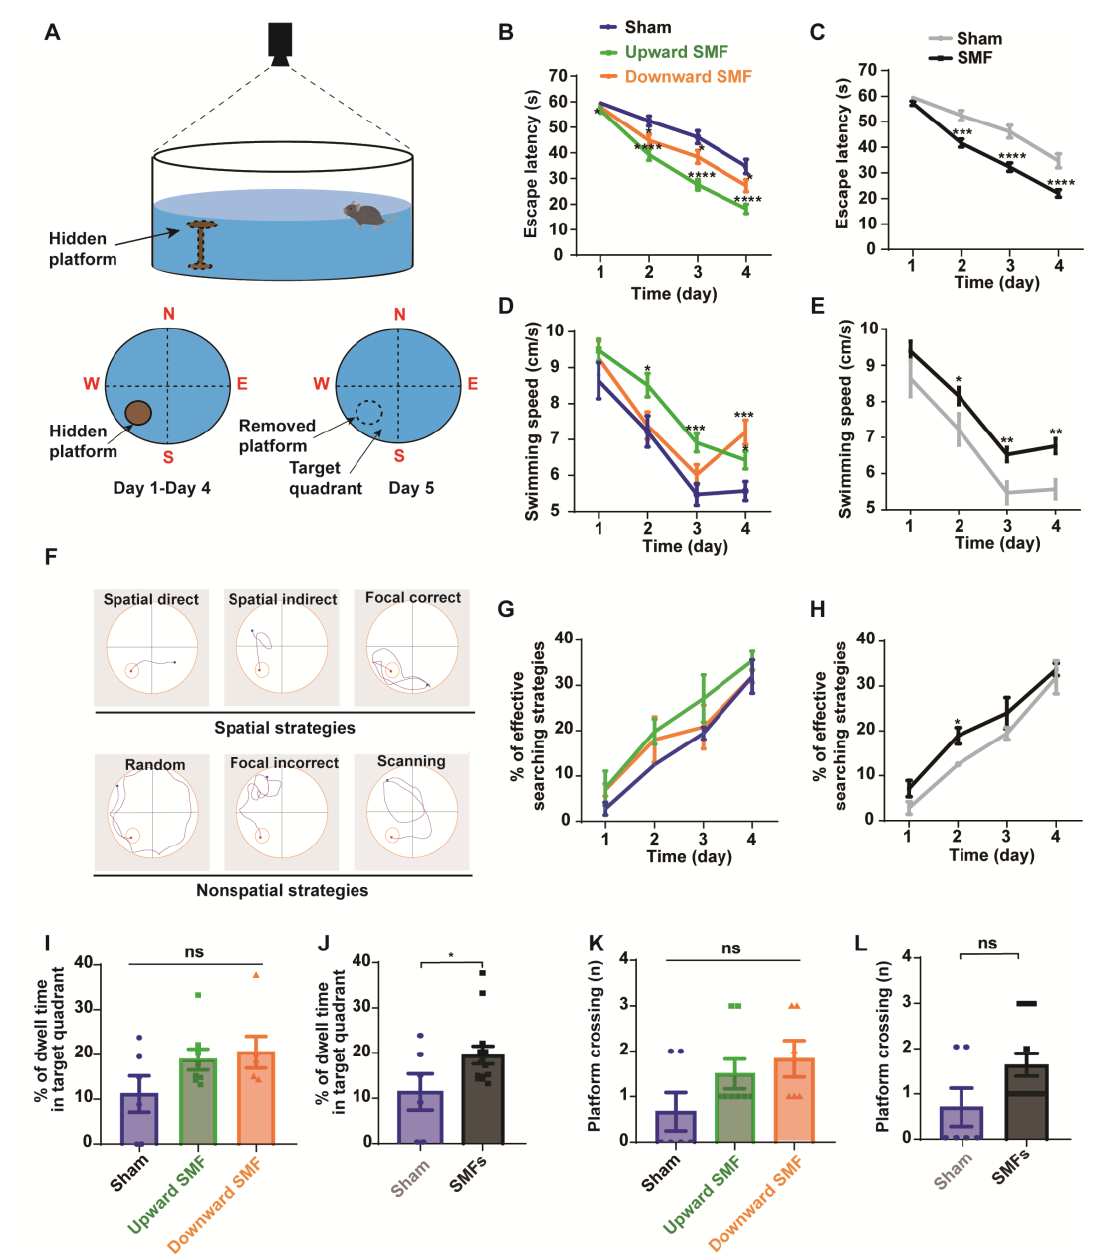
Figure 4. Morris water maze test shows that SMFs could improve spatial learning ability and spatial memory of aged mice. ( A ) Illustration of Morris water maze device, ( B , C ) escape latency during the spatial acquisition training days, ( D , E ) swimming speed during the spatial acquisition training days, ( F ) different types of search strategies during the spatial acquisition training days, ( G , H ) the percentage of effective searching strategies during the spatial acquisition training days, ( I , J ) the percentage of dwell time in the target quadrant during the probe trial, ( K , L ) platform crossing during the probe trial were recorded and analyzed in a blinded way. Mice in upward or downward SMF exposure groups were analyzed separately ( B , D , G , I , K ) or grouped together as SMF group ( C , E , H , J , L ). n = 6–8 mice for the sham, upward SMF or downward SMF group. Values were expressed as means ± SEM. * p < 0.05, ** p < 0.01, *** p < 0.001, and **** p < 0.0001 by Student’s t -test. ns, no